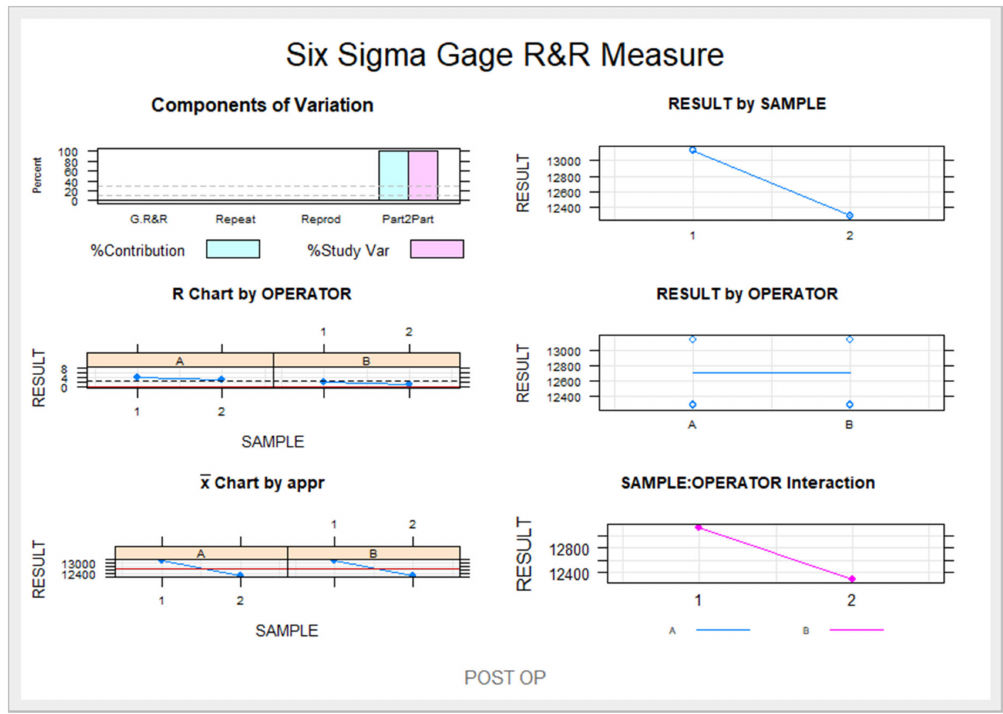
Figure 7. Measurement system analysis related to the volume of the right maxillary sinus, left maxillary sinus, and the nasal and maxillary sinus airway complex with a chart showing the influence of each component on the total variance (Components of Variation), a mean control chart, a range control chart (R Chart by OPERATOR and x Chart by appr), every point measured in the graph (RESULT by SAMPLE and RESULT by OPERATOR), and the relationship between the operators’ findings (SAMPLE: OPERATOR